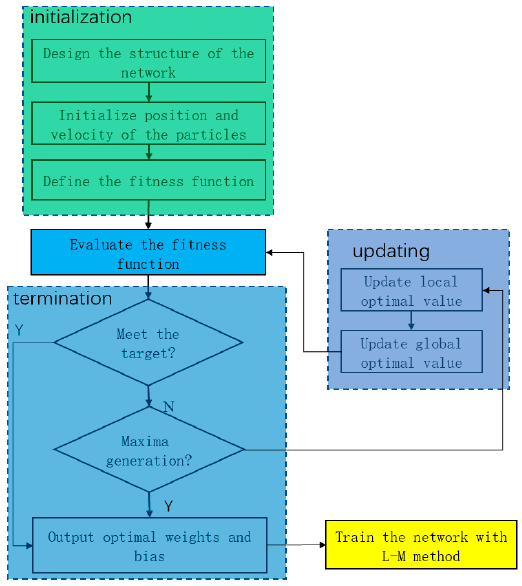
Figure 6. Flowchart for PSO.